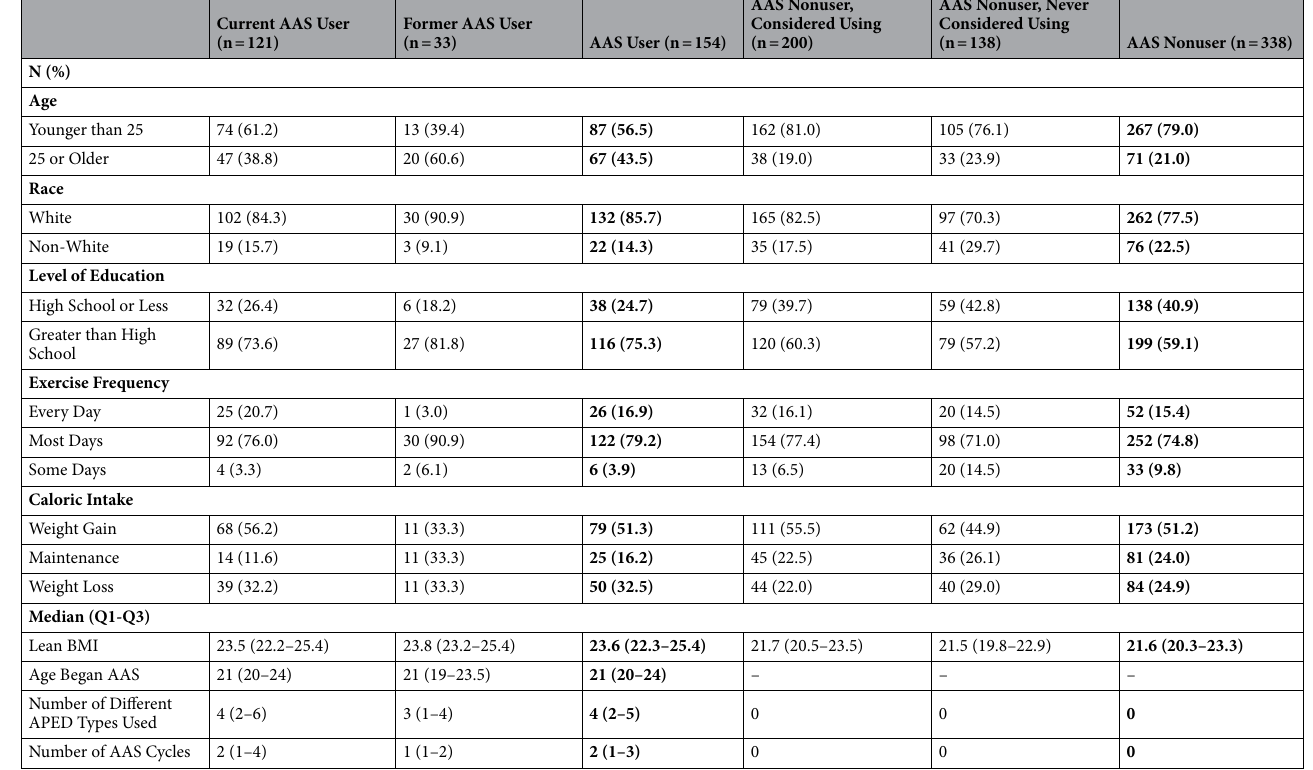
Table 1. Participant characteristics. Overall columns for primary analysis (AAS User, AAS Nonuser) are in